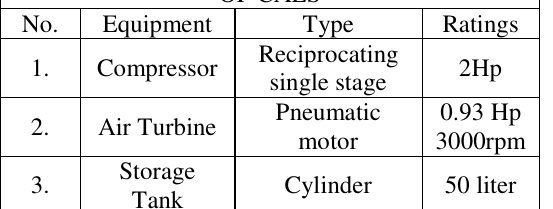
TABLE 2. RATINGS OF MAIN COMPONENT